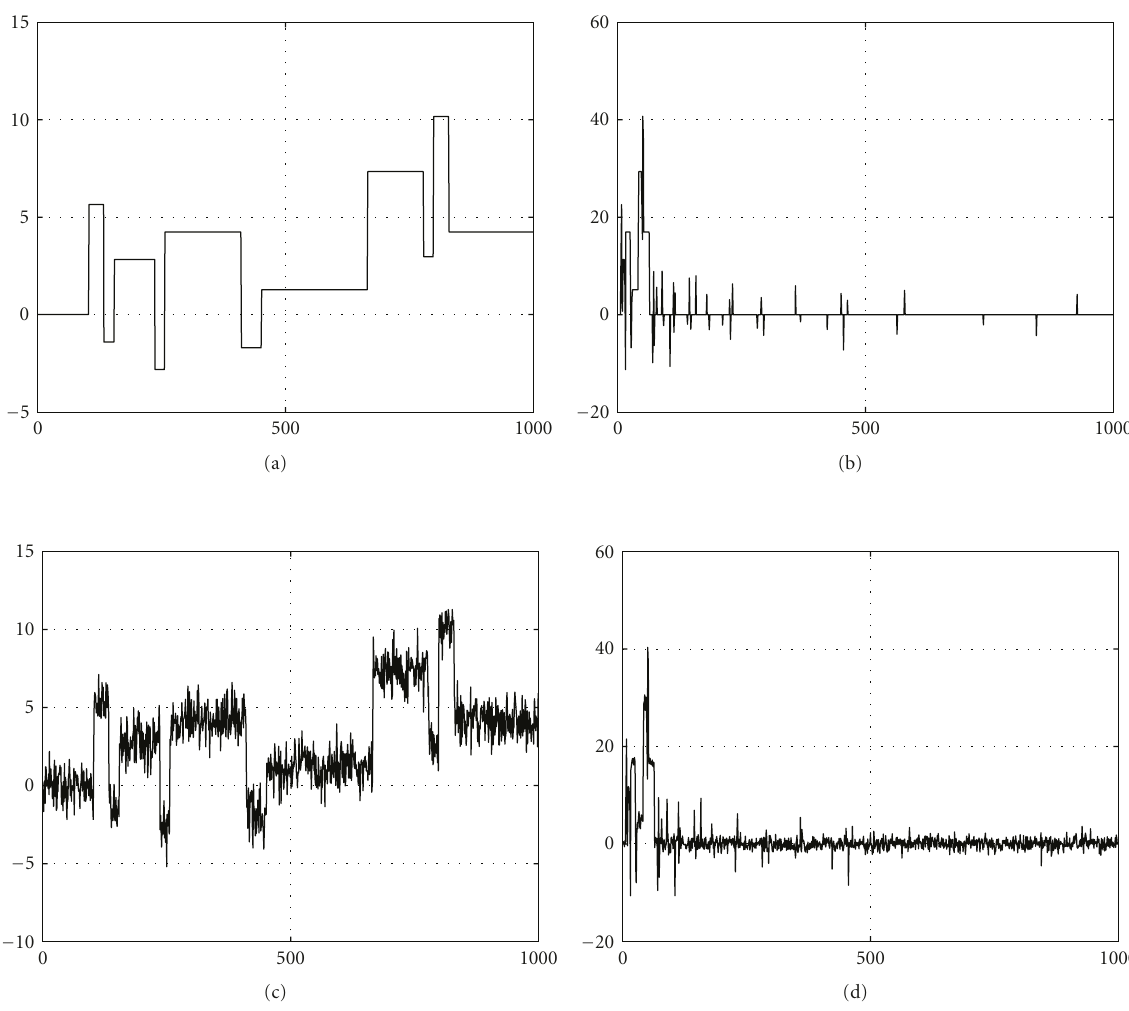
Figure 2: (a) Blocks signal with length 1024, (b) wavelet coe ffi cients, (c) noisy blocks signal with additive white noise, σ w = 1, and (d) noisy coe ffi